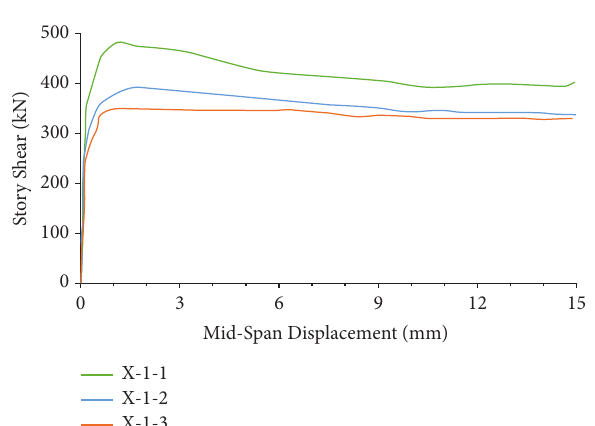
Figure 19: Diagram of story shear versus midspan displacement for models with different opening area under loading in X